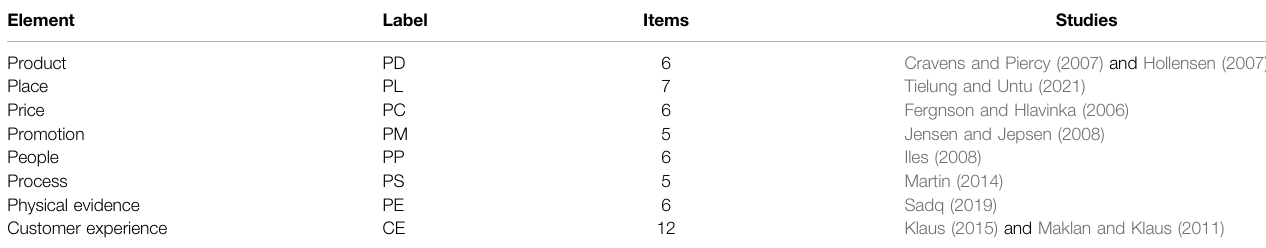
TABLE 1 | Adopting variables from previous studies. Element Label